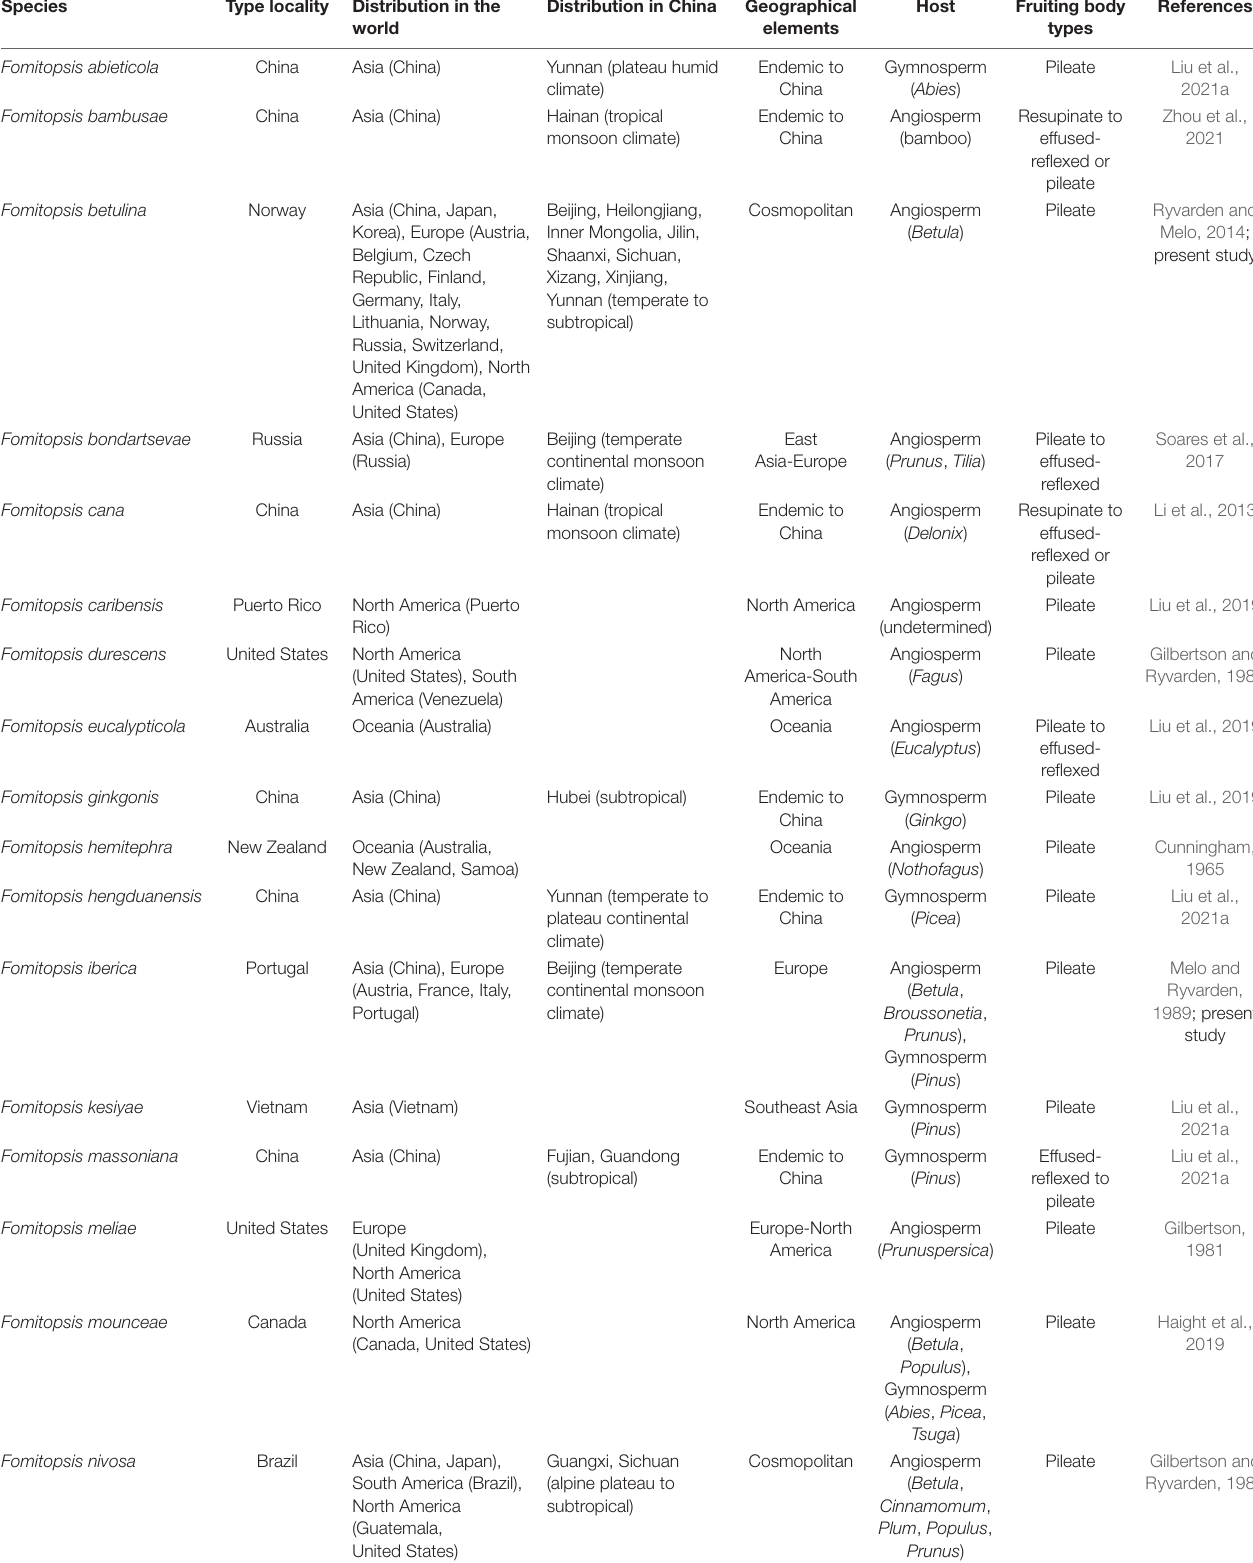
TABLE 2 | The main ecological habits of Fomitopsis with an emphasis on distribution areas, host trees, and fruiting body